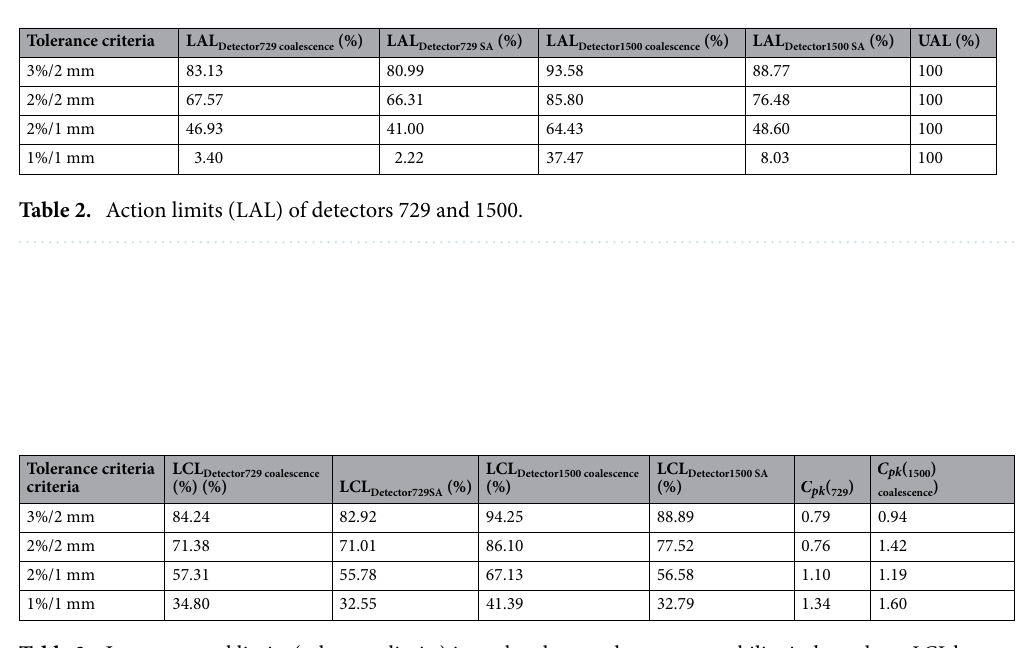
Tolerance criteria